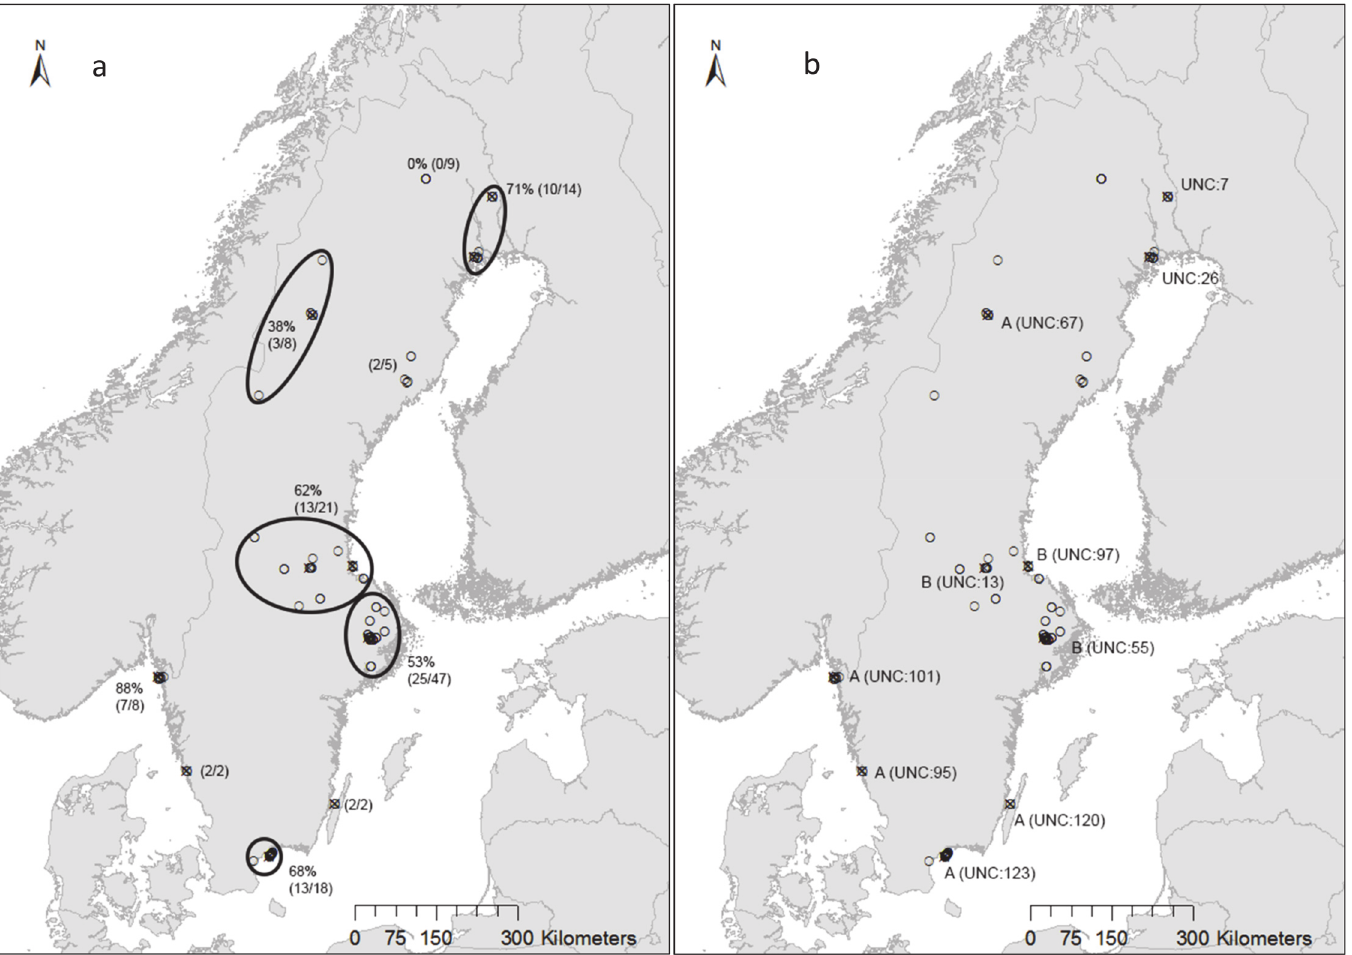
Fig 1. Free-ranging mink sampled for AMD antibody and AMDV virus detection (small circles) and virus sequence analysis (crosses). 1a) Percentage positive mink (by PCR)/total mink within each area (areas within ellipses are calculated together). 1b) Crosses are labelled with UNC number and phylogenetic